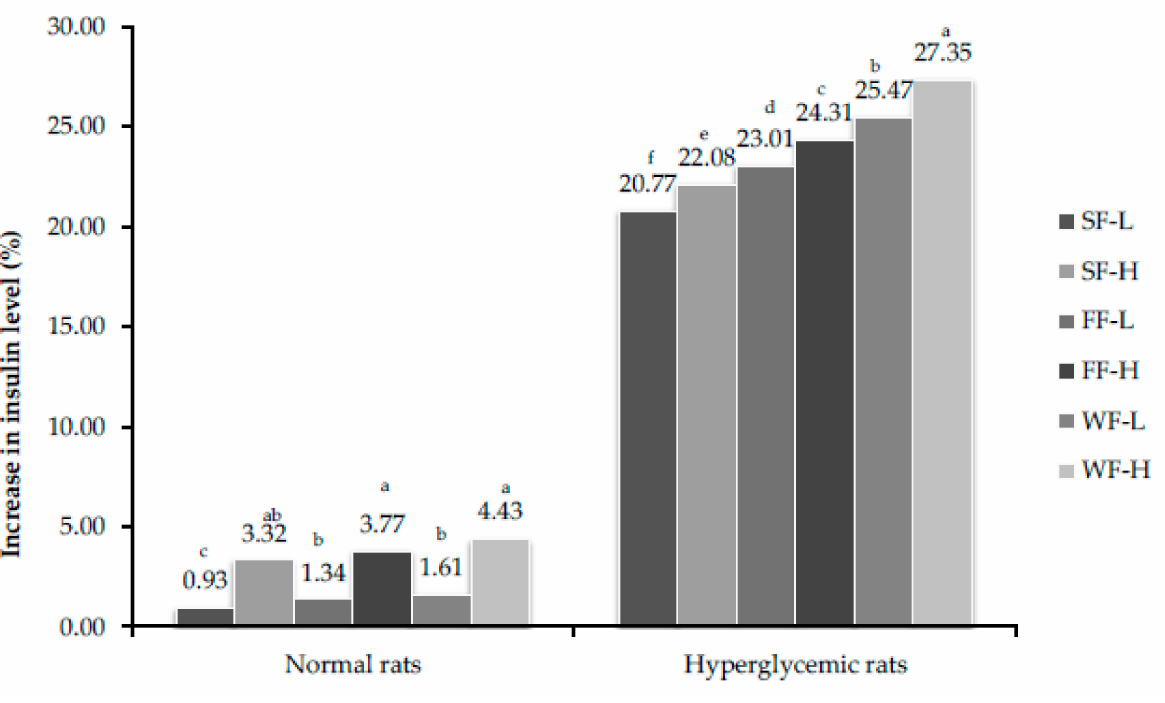
Figure 5. Percent increase in insulin level after feeding bitter gourd on 56th day. Bars that do not share similar letters denote statistical significance ( p <